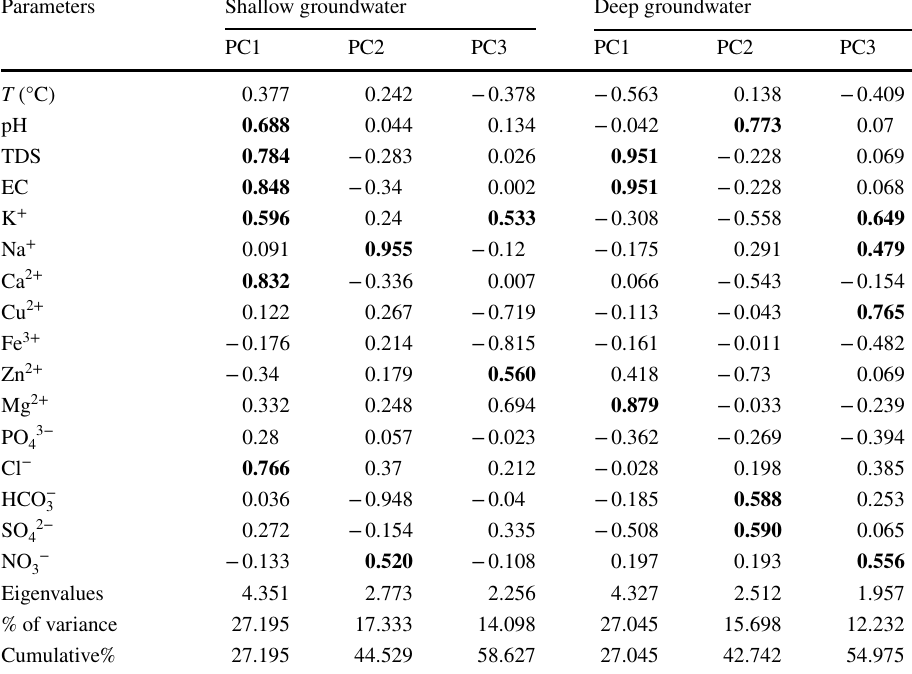
Table 11 Varimax rotated R-mode factor loadings matrix